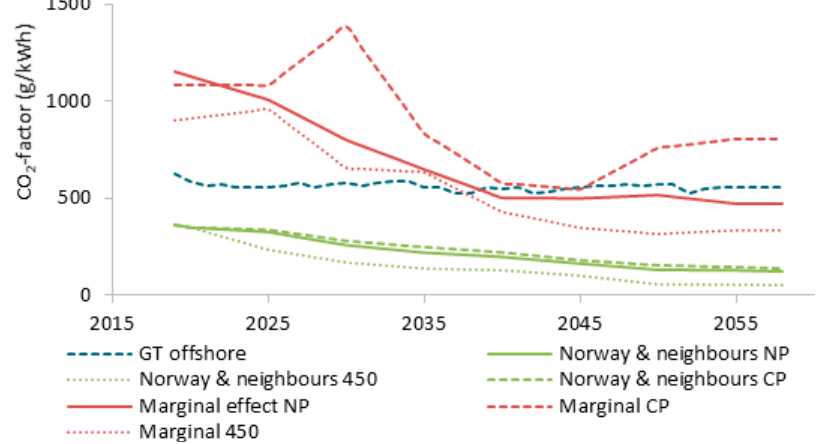
Figure 15. CO 2 -factors for the future scenarios considered calculated with two different approaches and adjusted for offshore supply.